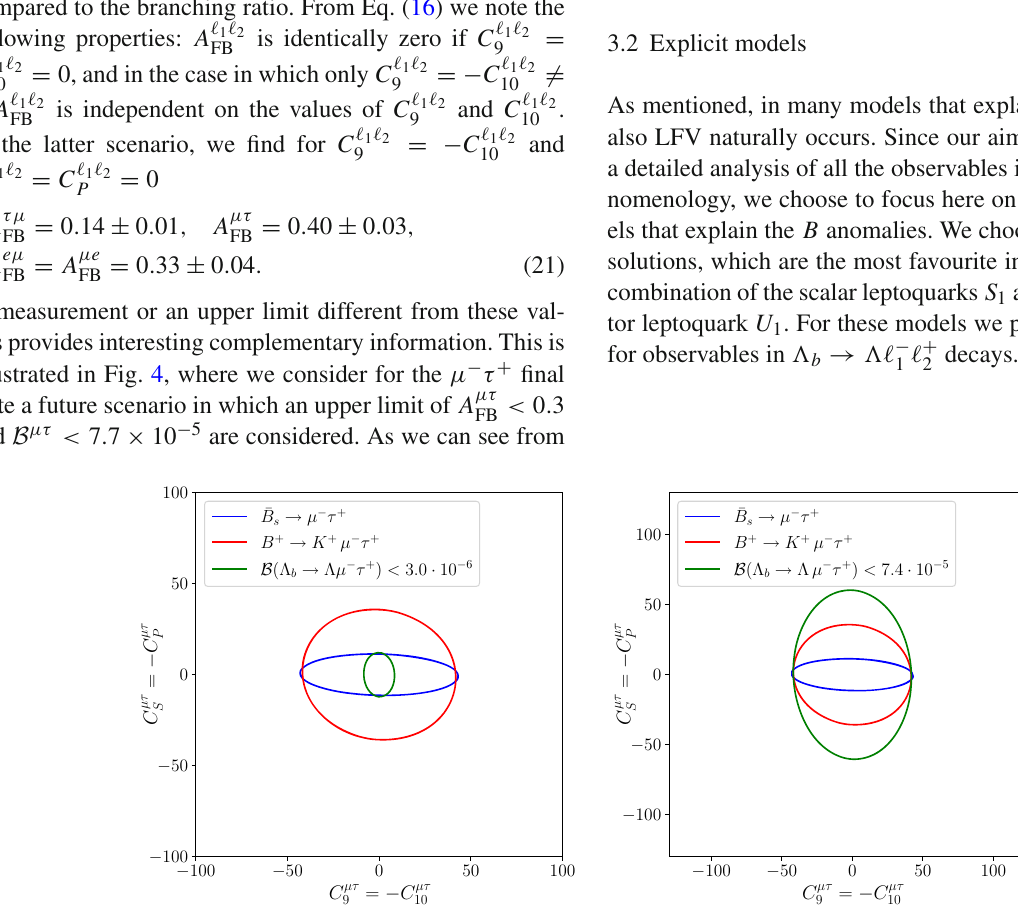
μτ < 0 . 3, FB τμ helps to rule out a large part FB (cid:3) (cid:3) − C (cid:3) 1 (cid:3) 2 1 2 plane. 9 10